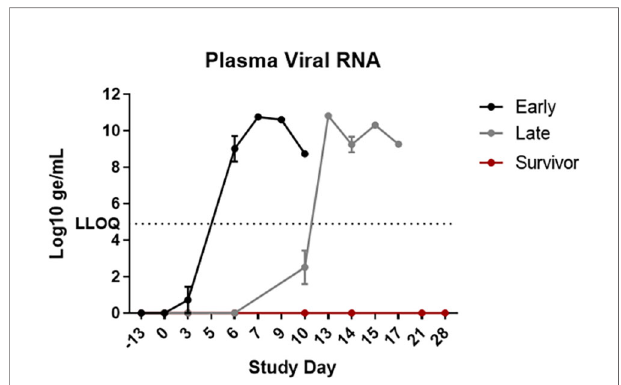
FIGURE 6 | Viral RNA in EDTA plasma. EBOV-speci fi c qRT-PCR was performed on RNA extracted from EDTA plasma. Data are shown as Log10 ge/ mL. The graphs in this fi gure show data grouped by survival phase (i.e., early- phase, late-phase, and survivor). LLOQ, lower limit of quanti fi cation. Error bars represent the